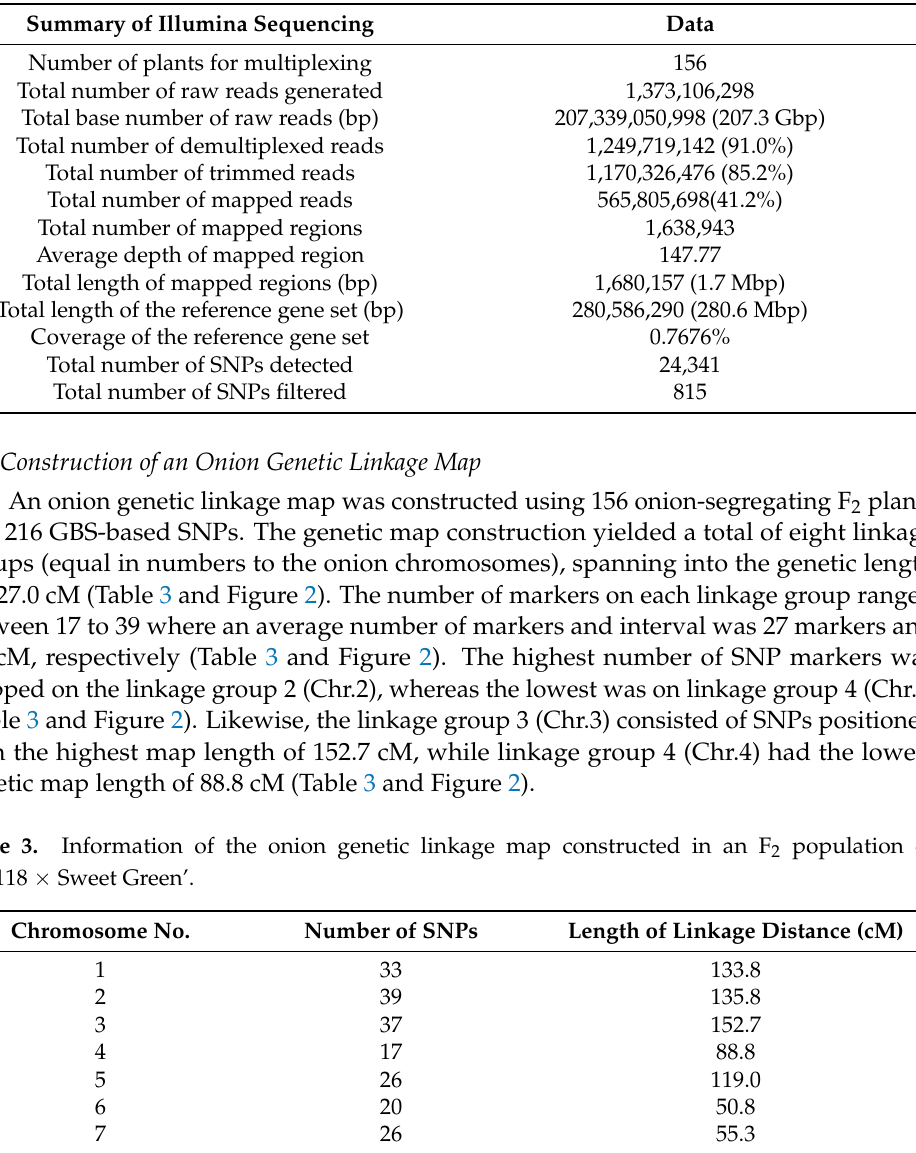
Table 2. Summary of genotyping by sequencing data generated by using transcriptome sequences as a reference.